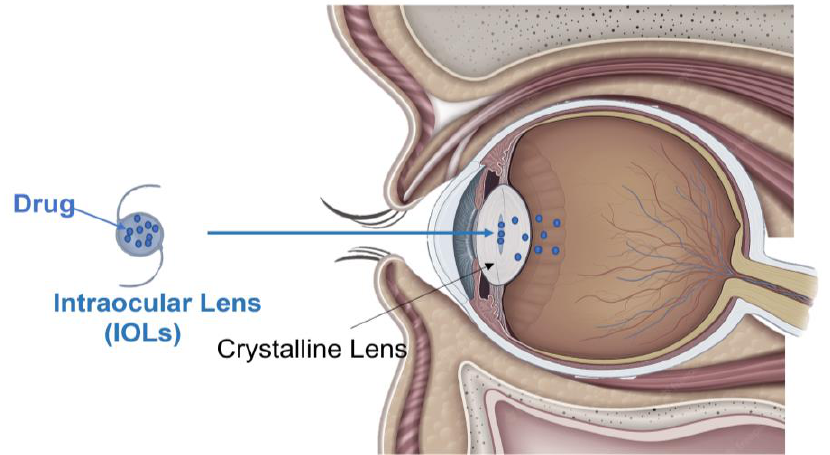
Figure 4. Representative image of a drug-loaded intraocular lens (IOL). A drug-loaded IOL is a permanent, tiny synthetic ocular device composed of acrylic and silicone. Once implanted during cataract surgery into the crystalline lens, it allows sustained intraocular drug release through the diffusion process.